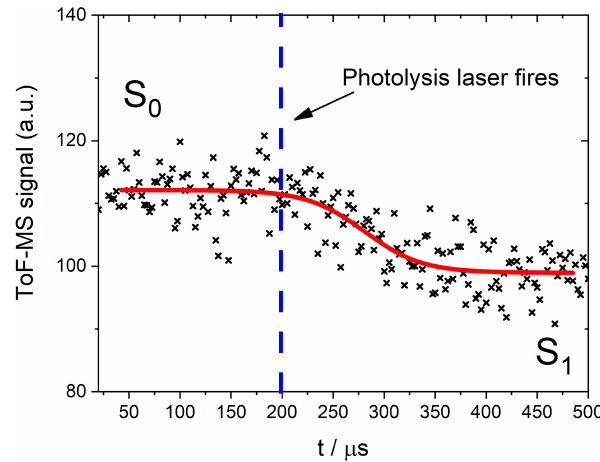
Figure 4. Schematic of a photodepletion measurement of NO 2 . The red curve is an empirical fit through the data performed to obtain the values of S 0 and S 1